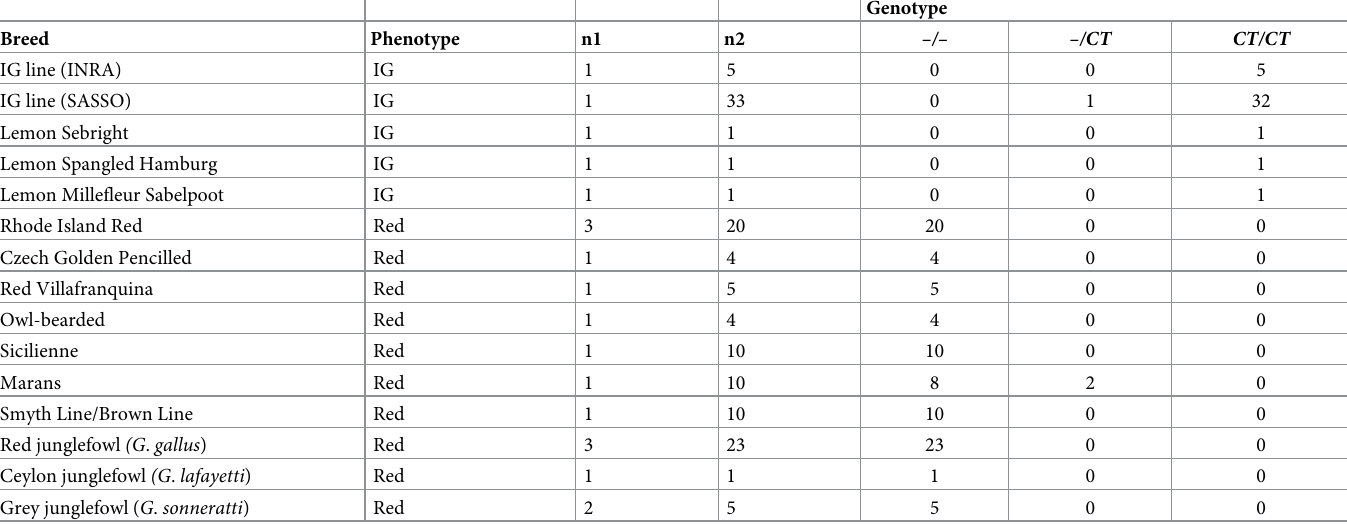
Table 3. Genotype distribution of the 2-bp insertion in COMTD1 associated with the Inhibitor of Gold (IG) phenotype in different populations sorted by